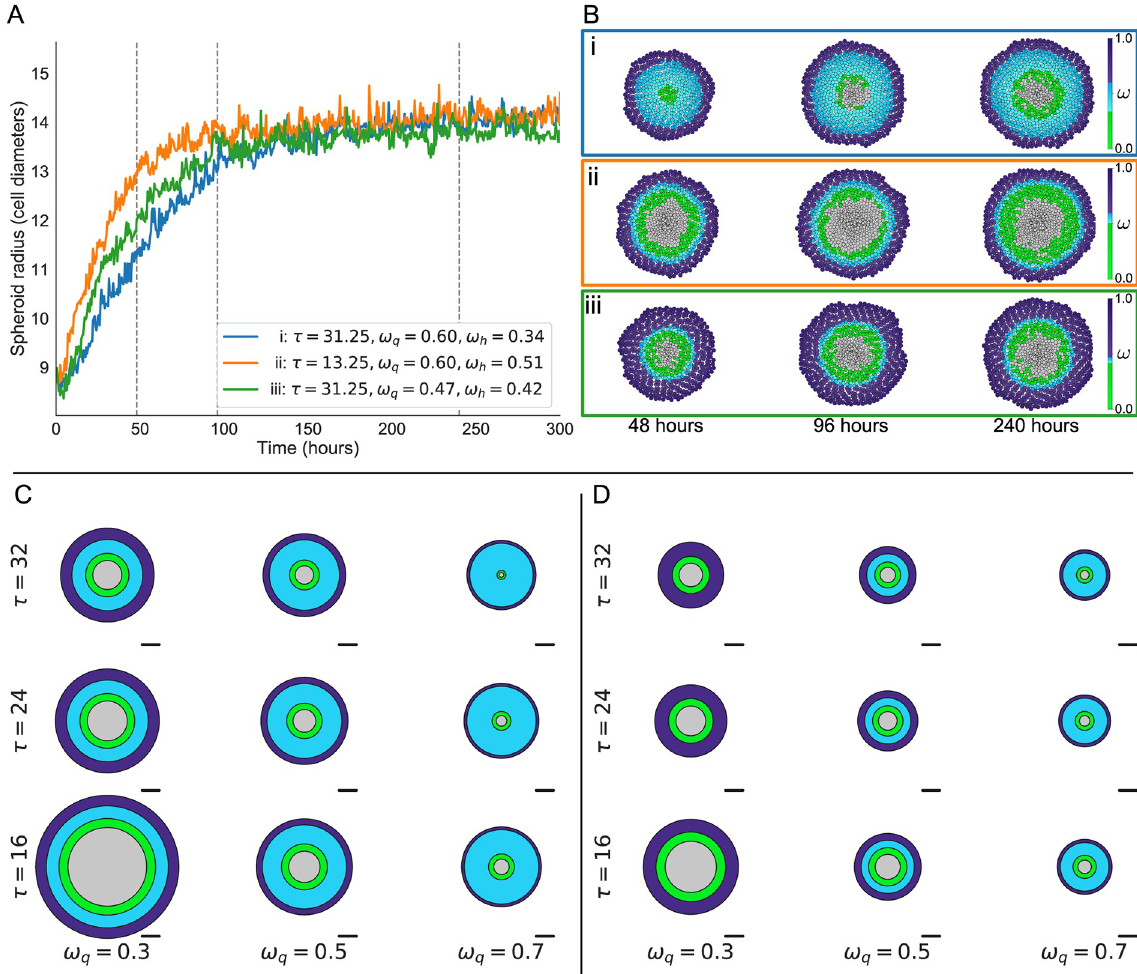
Fig 4. Spheroids with similar growth dynamics can have different compositions. A: Tumour radius over time for three spheroids generated from different parameter sets which give rise to spheroids with approximately the same steady state radius. B: Snapshots of the simulations in A. Cells are coloured according to their oxygen concentration and phenotype. By varying the thresholds ω q and ω h , and the growth rate τ , we can generate spheroids with similar growth dynamics and steady state radii which have different internal compositions. Spheroids i and ii have the same ω q , but differ in ω h and τ . Spheroids i and iii have the same τ , but differ in ω q and ω h . Spheroid i (blue line) contains a large number of quiescent cells and has a slow growth rate, but has a low oxygen threshold before cells become hypoxic. Cells in Spheroid ii (yellow line) proliferate more quickly than in Spheroid i, but since ω h is higher the spheroid has a larger necrotic core at steady state. Spheroid iii (green line) also has only a narrow quiescent region, but possesses a thicker proliferative rim than spheroid ii. C and D: Average spheroid sizes and compositions change as ω q and τ vary, averaged over 50 repetitions for each parameter set (with ~ t ¼ 8 and ω h = 0.1 (C) or ω h = 0.3 (D)). Scale bars are 10 cell diameters in length.